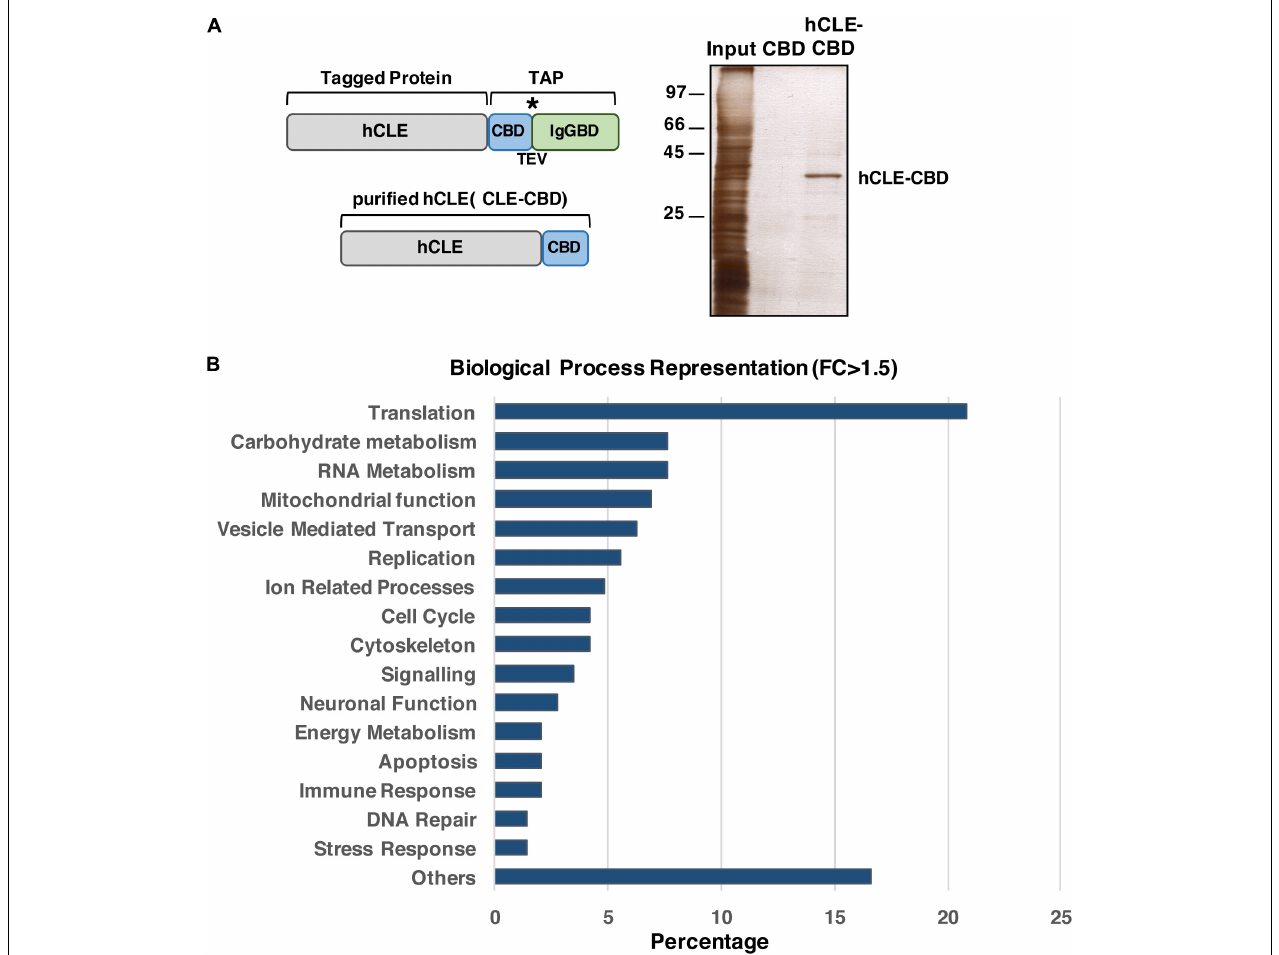
FIGURE 7 | hCLE binds specific messenger RNAs. (A) Scheme of the hCLE-TAP fusion protein used for tandem affinity purification (TAP) and the final purified protein hCLE-CBD. Peptides bearing the calmodulin-binding domain (CBD) and the IgG-binding domain of Staphylococcus aureus protein A (IgGBD) are separated by a cysteine protease (TEV) cleavage sequence. (B) Silver staining of hCLE-CBD purified protein used for high throughout sequencing. (C) Percent representation of mRNAs associated to hCLE-CBD, grouped by biological function according to GeneOntology annotations. Two biological replicates were used. ∗ represents the TEV protease cleavage